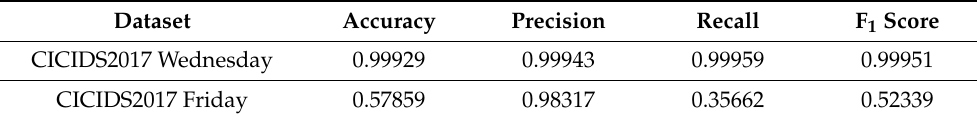
Table 6. Detecting results on unknown attack from CICIDS2017 Friday.